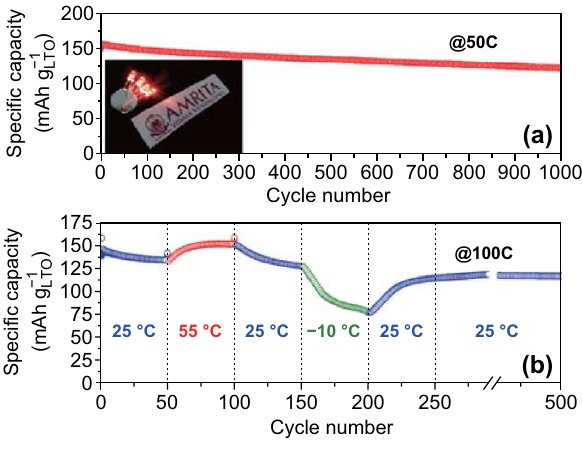
Fig. 5 Electrochemical cycling stability and operation temperature of the full cell. a Long-cycling performance at 50 C (both charge and discharge). b Performances at different temperatures (shown in the legend) for cycling at 100 C . The inset in ( a ) shows that the four light- emitting diodes could be lit by the coin cell, which demonstrates the high-power